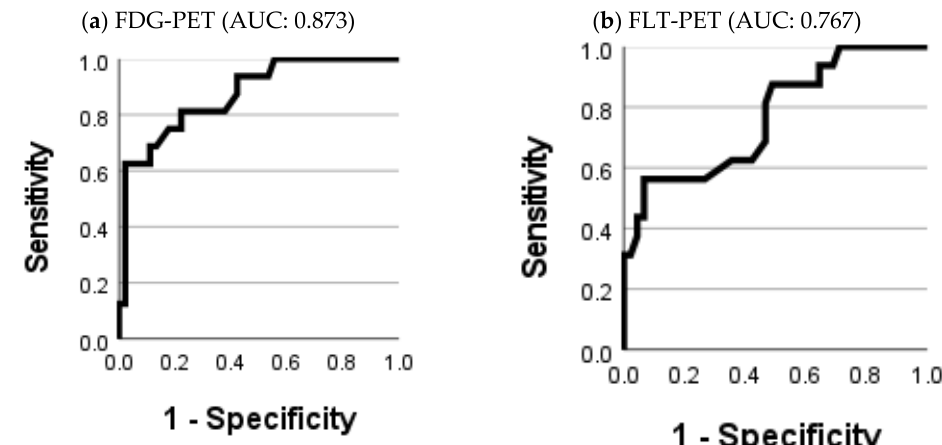
Figure 6. Receiver operating characteristic (ROC) curves for the relapse diagnosis with FDG-SUV max ( a ) and FLT-SUV max ( b ).